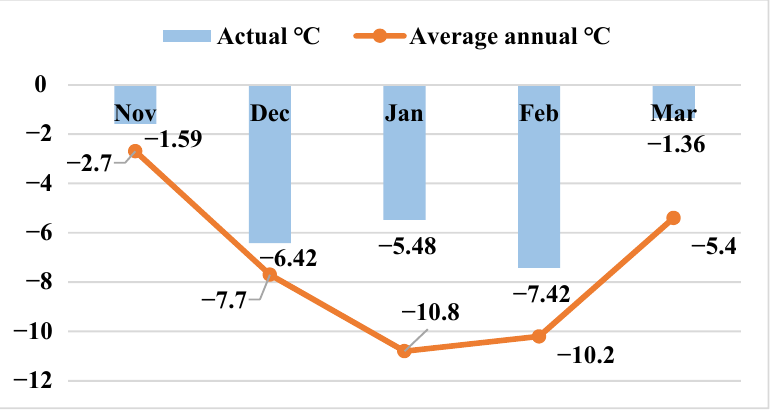
Figure 3. Average monthly temperatures in the epiphytotic years.